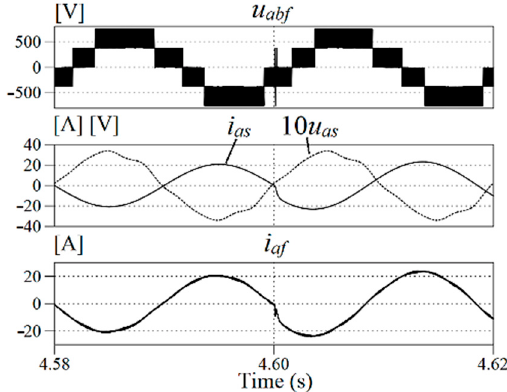
Figure 19. Waveforms of the phase-to-phase voltage of the power grid inverter u abf , voltage u as and current i as of the grid, and inverter current i af for change in reactive power.